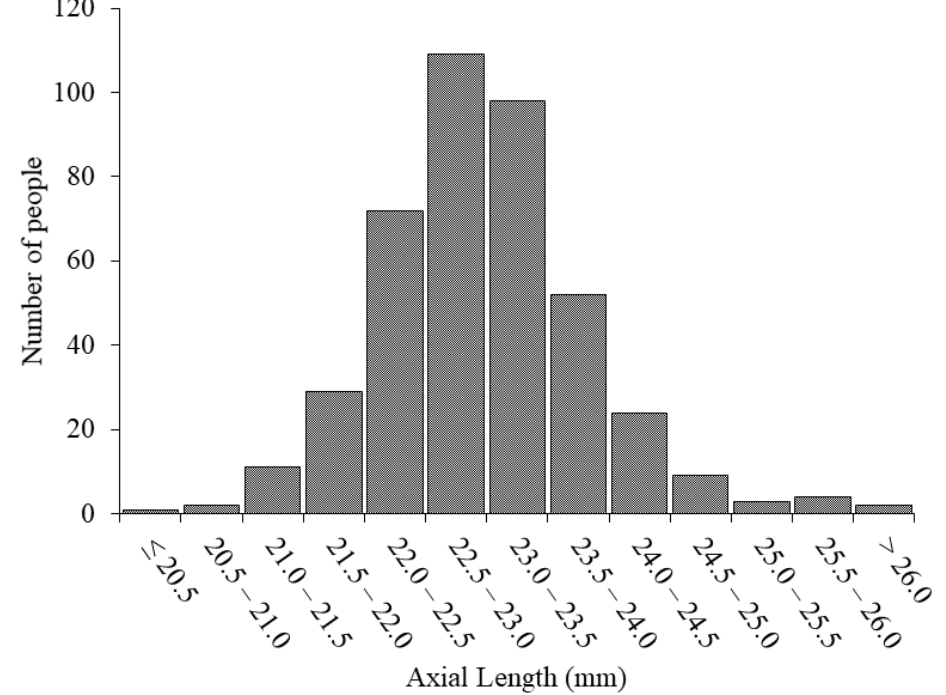
Figure 3. The distribution of the axial lengths (ALs). The ALs of the participants in this study were primarily in the 21.0 to 24.5 mm range (average, 22.98 mm). The prevalence of myopia (SE ≤ − 0.75 D) was 20.4%, and the prevalence of high my- opia (SE ≤ − 6.0 D) was 1.4% among all the students. Based on the AL, the prevalence of high myopia (AL ≥ 26.0 mm) was 0.48% among all the students.